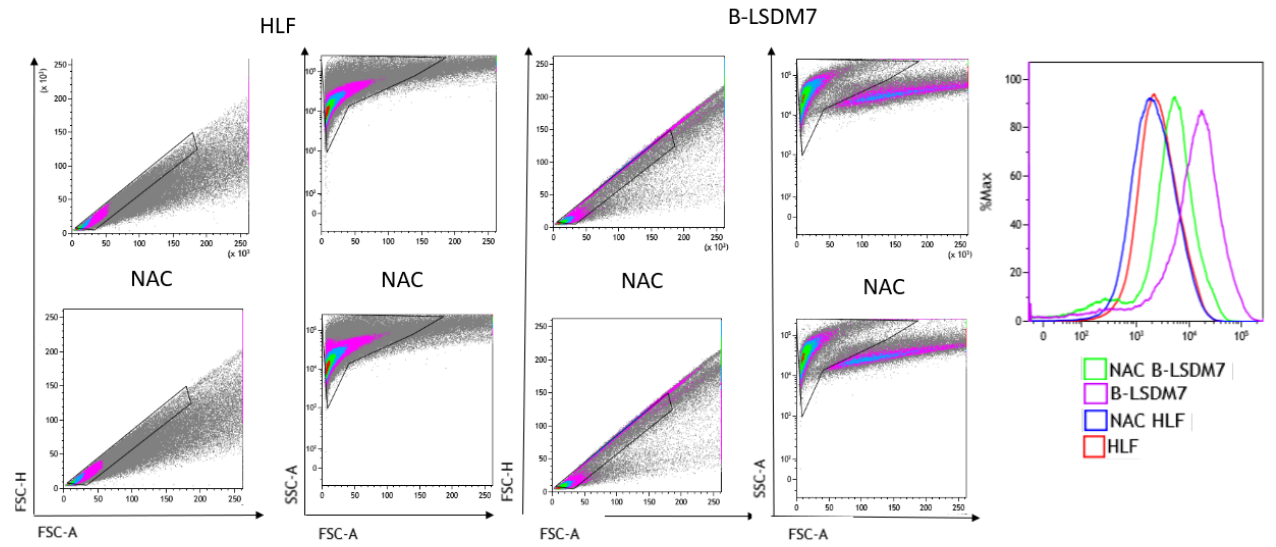
Figure 8. The detection of reactive oxygen species (ROS) through Flow cytometric analysis. The use of N-acetil cysteine was applied as anti-oxidant. The status of oxidation of B-LSDM and HLF were performed through CellROX® Green Flow Cytometry Assay Kits.